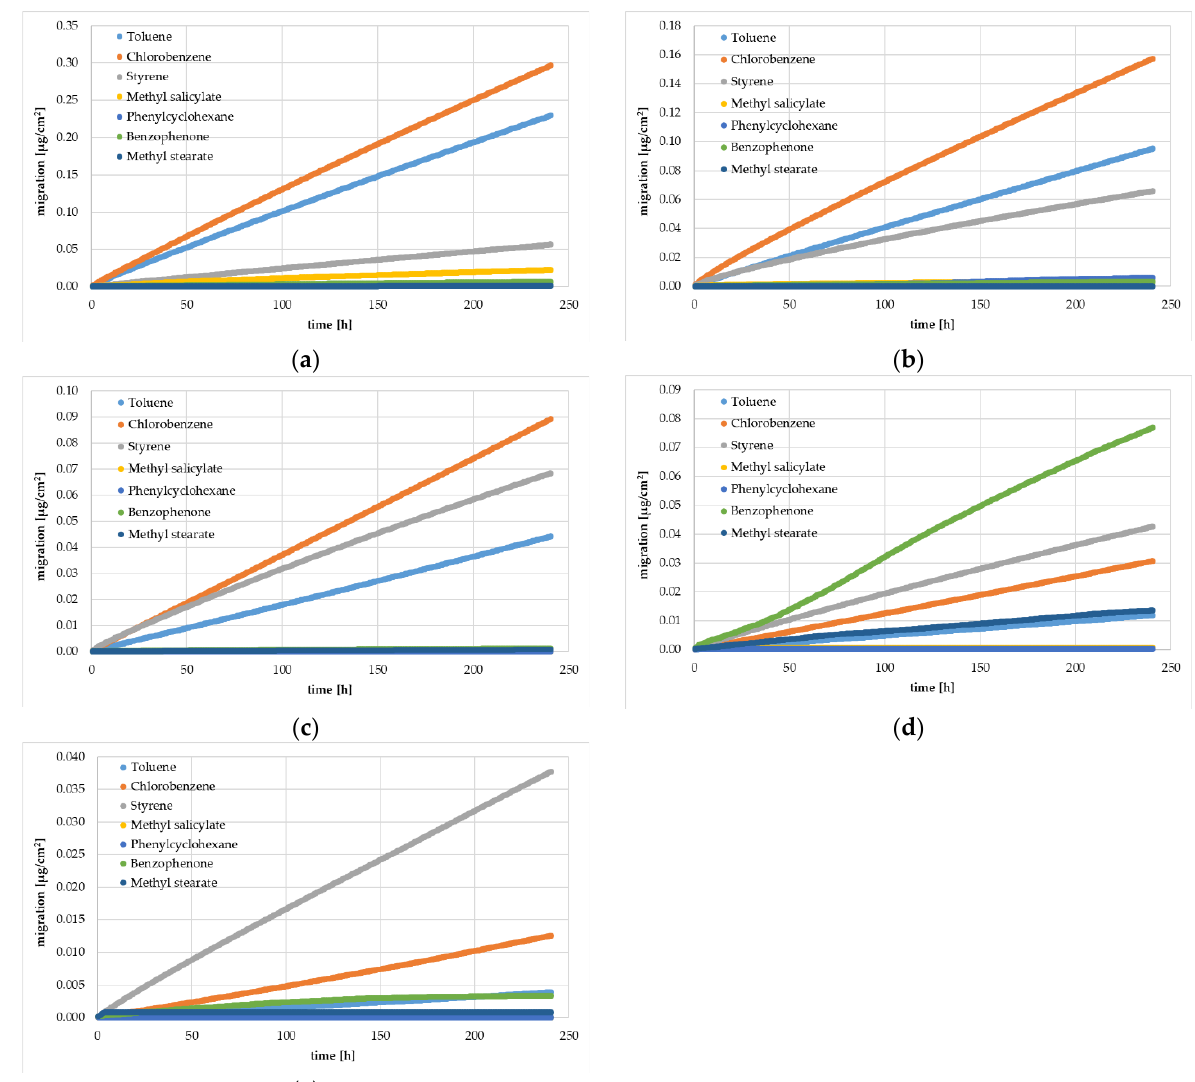
Figure 1. Experimentally determined gas phase migration kinetics (360 kinetic points) from HIPS yogurt cups at 40 °C: Sample 0 ( a ), Sample 1 ( b ), Sample 2 ( c ), Sample 3 ( d ), and Sample 4 ( e ). Spiking levels for the different substances are indicated in Table 1.